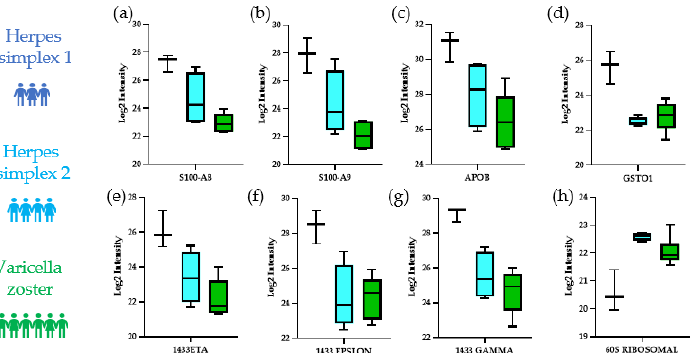
Figure 4. Boxplot analysis of ANOVA significant proteins between HSV-1, HSV-2, and VZV. Log2 intensity values are plotted. ( a ) Protein S100-A8 (S10A8) ( p = 1.50 × 10 − 3 ); ( b ) Protein S100-A9 (S10A9) ( p = 1.20 × 10 − 3 ); ( c ) Apolipoprotein B-100 (APOB) ( p = 1.04 × 10 − 2 ); ( d ) Glutathione S-transferase omega-1 (GSTO1) ( p = 4.00 × 10 − 4 ); ( e ) 14-3-3 protein eta (1433F) ( p = 4.00 × 10 − 3 ); ( f ) 14-3-3 protein epsilon (1433E) ( p = 5.00 × 10 − 3 ); ( g ) 14-3-3 protein gamma (1433G) ( p = 1.00 × 10 − 4 ); ( h ) 60S ribosomal protein L34 (RL34) ( p = 1.00 × 10 − 4 ).